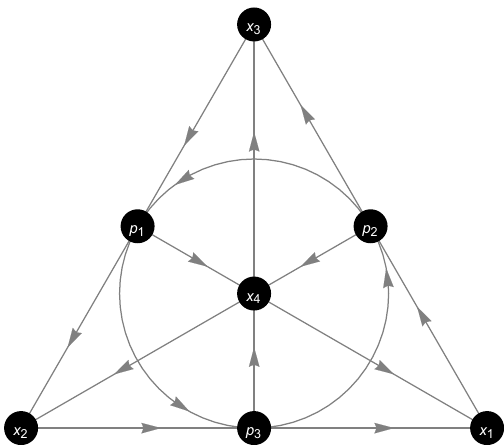
Figure 1 . Commutation relations of the nonassociative R -(cid:13)ux algebra. The commutator of two phase space coordinates is given by the third node along the line connecting the two. If the arrow points from the (cid:12)rst to the second element of the commutator, one has a factor of i on the right-hand side, otherwise (cid:0) i